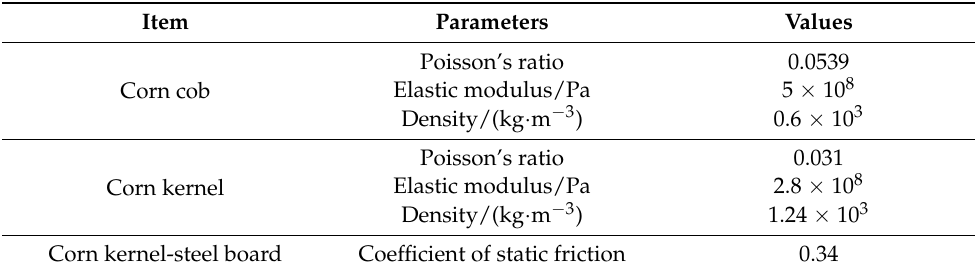
Table 2. Simulation parameters settings.